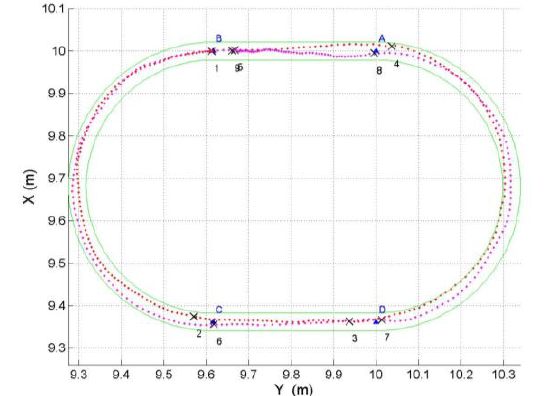
Figure 9. Rail-bound navigation position